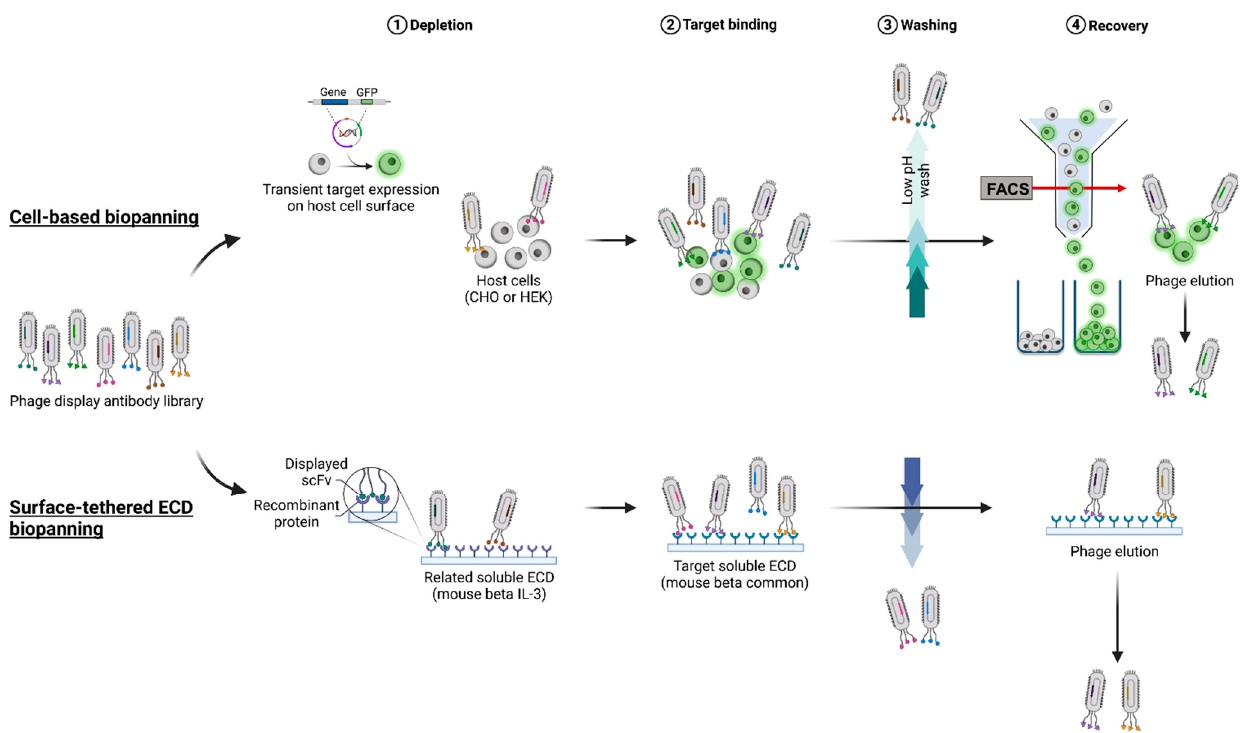
Figure 1. Schematic overview of STRE and CBA biopanning strategies. Initially, a naïve phage display single-chain antibody library was exposed to the related antigen m β IL-3 (STRE biopanning) or cells devoid of the target receptor (CBA biopanning) in a depletion step. Next, remaining phages were allowed to bind to the target antigen (m β c), and non-specifically bound particles or those with low affinity were eliminated by a low pH washing step. Finally, target-specific bound phages were recovered by elution.